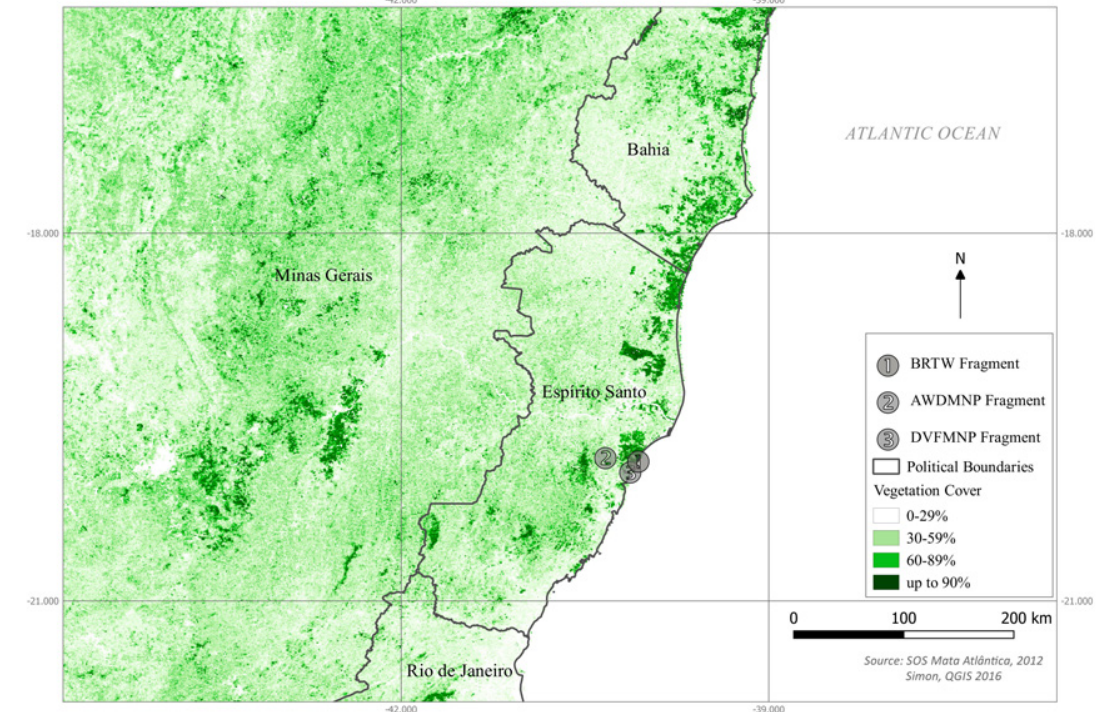
Fig 1 . Map of Espírito Santo State indicating the study area. (1) BRTW: Barra do Riacho Terminal Waterway; (2) AWDMNP: Aricanga Waldemar Devens Municipal Natural Park; (3) DVFMNP: David Victor Farina Municipal Natural